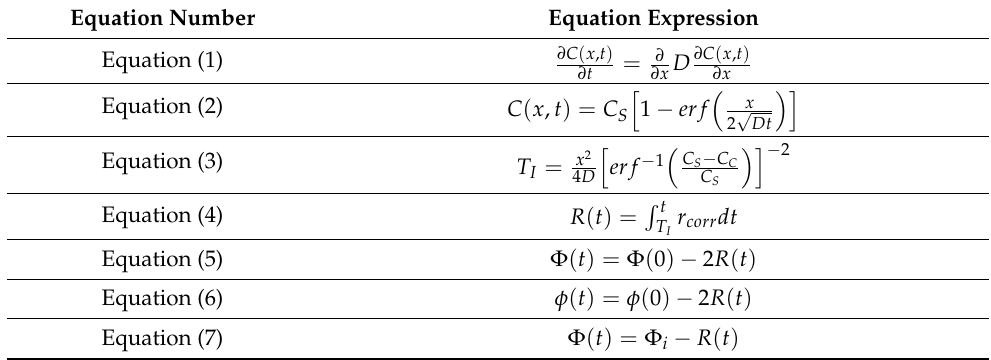
Table 1. Equation list for Section 2.